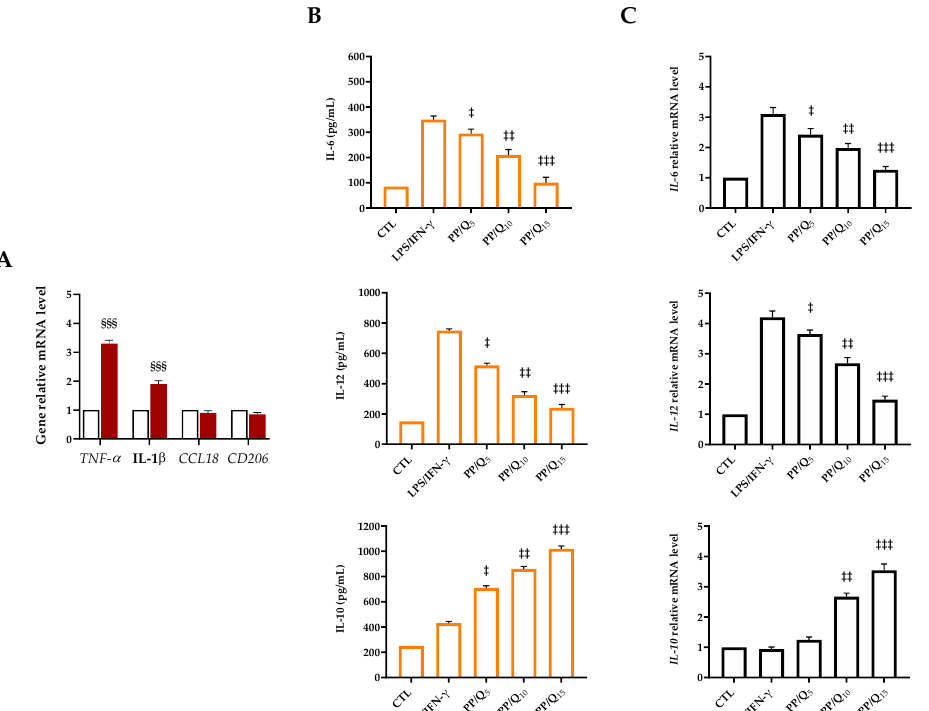
Figure 5. ( A ) mRNA expression of M1 macrophage markers after LPS/IFN- γ stimulation (10 pg/mL LPS + 20 ng/mL IFN γ ) for 24 h analyzed by RT-qPCR. Stimulated macrophages were compared with unstimulated cells used as control (CTL). Data are represented as fold change over β -actin (2 − ∆∆ Ct ). Results are expressed as the mean of three independent experiments ± S.D (n = 3). Statistically significant variations §§§ p < 0.001 versus CTL. Inhibitory effects of QUE on the secretion ( B ) and gene expression ( C ) of inflammatory mediators IL-6, IL-12 and IL-10 in LPS/IFN- γ stimulated macrophages measured by ELISA assay and RT-qPCR. THP-1 cells were pre-treated with PP/Qx membranes for 24 h, then stimulated with LPS/IFN- γ for 24 h. PMA-differentiated THP-1 macrophages seeded on the culture plate without LPS/IFN- γ stimulation were used as control (CTL). Results are expressed as the mean of three independent experiments ± S.D (n = 3). Statistically significant variations ‡ p < 0.05, ‡‡ p < 0.01, and ‡‡‡ p < 0.001 versus LPS/IFN- γ . With the purpose to obtain vascular tissue regeneration, Gui and colleagues manu- factured a polycaprolactone (PCL) vascular graft incorporated with quercetin